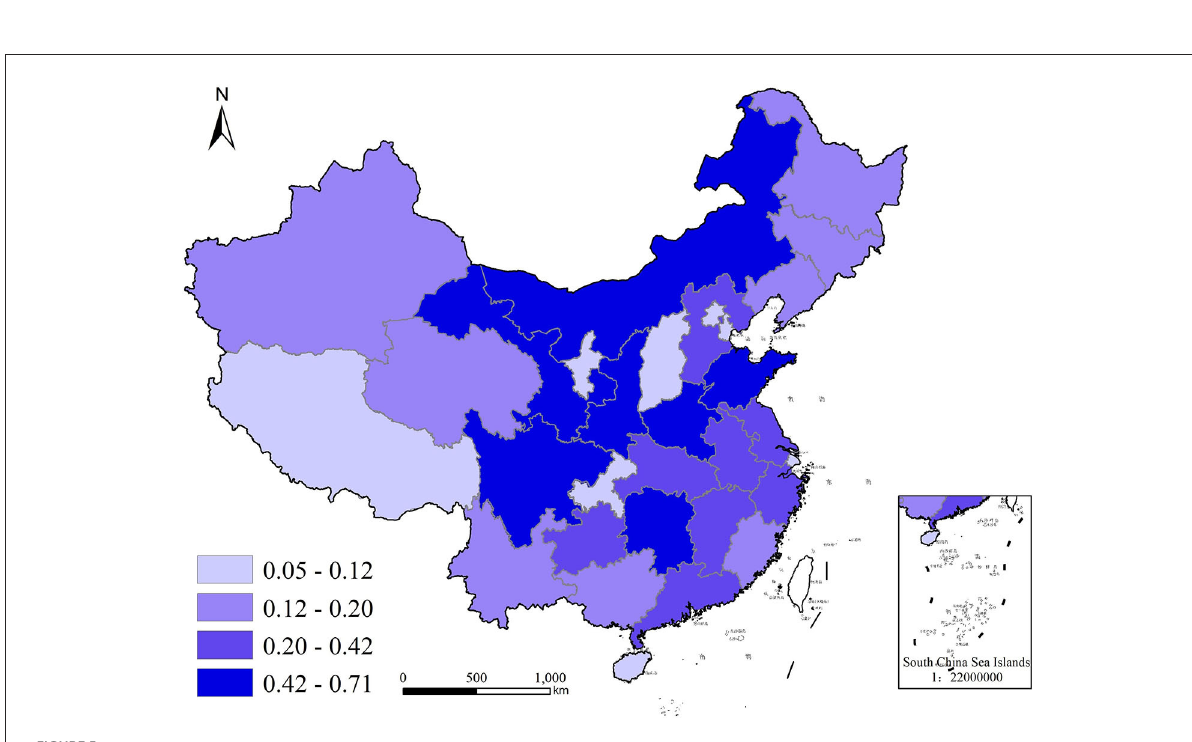
FIGURE5 Public health education in China in